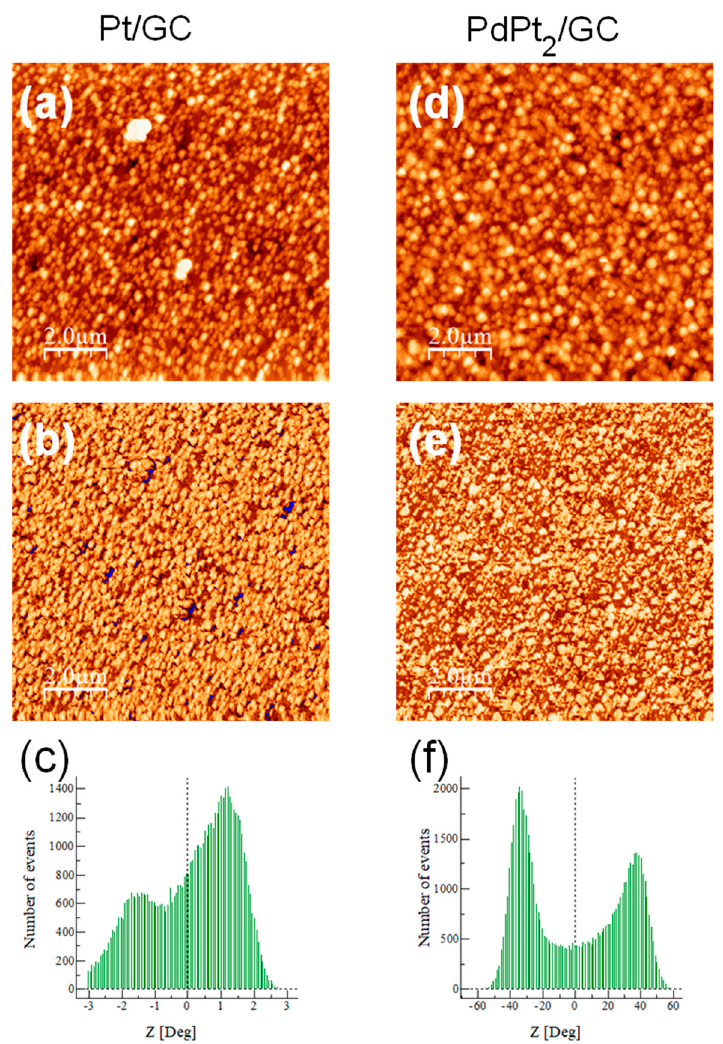
Figure 5. AFM images of Pt/GC surface obtained by the electrochemical Pt deposition (left column), and PdPt 2 /GC surfaces obtained by the additional spontaneous Pd deposition (right column): ( a ) and ( d ) height AFM images of Pt/GC (z − scale = 131 nm) and PdPt 2 /GC (z − scale = 118 nm); ( b ) and ( e ) phase AFM images of Pt/GC (z − scale = 7.2 Deg) and PdPt 2 /GC (z − scale = 7.2 Deg); ( c ) and ( f ) corresponding phase angle distributions showing the chemical difference between the constituents.